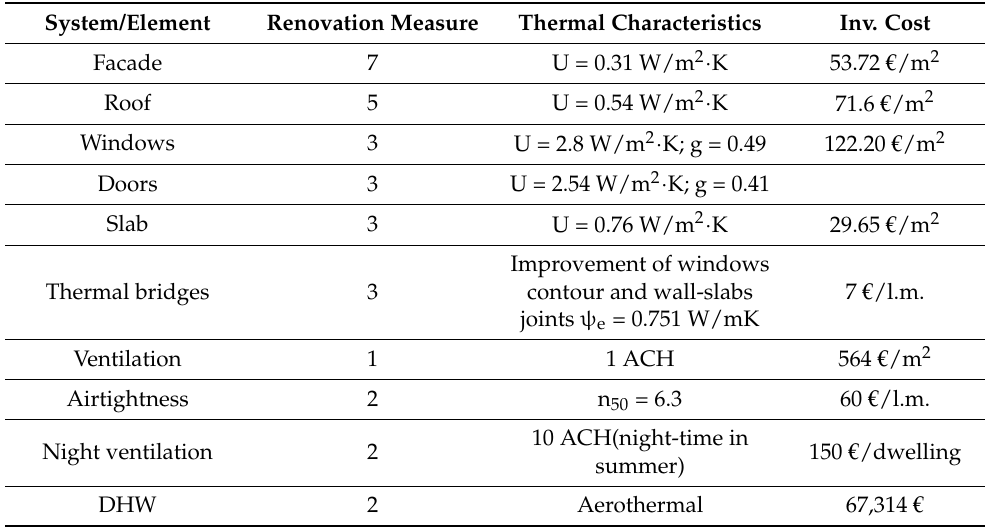
Table 7. Package of optimal solutions for the renovation